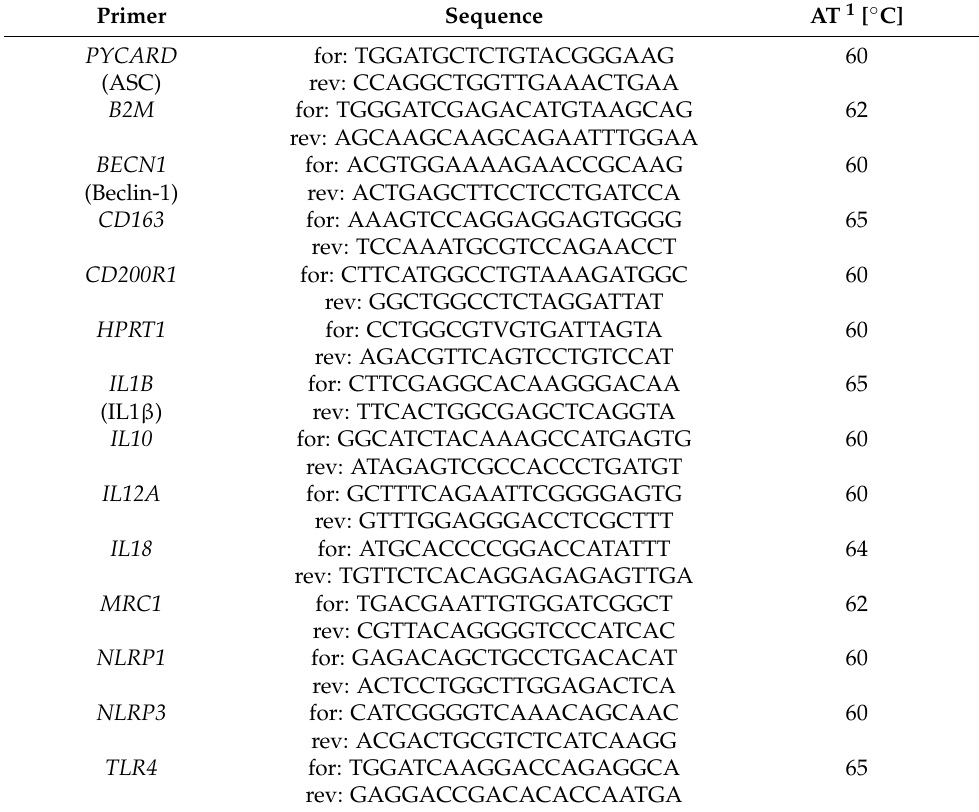
Table 1. List of primers used for qRT-PCR with their optimum annealing temperature.